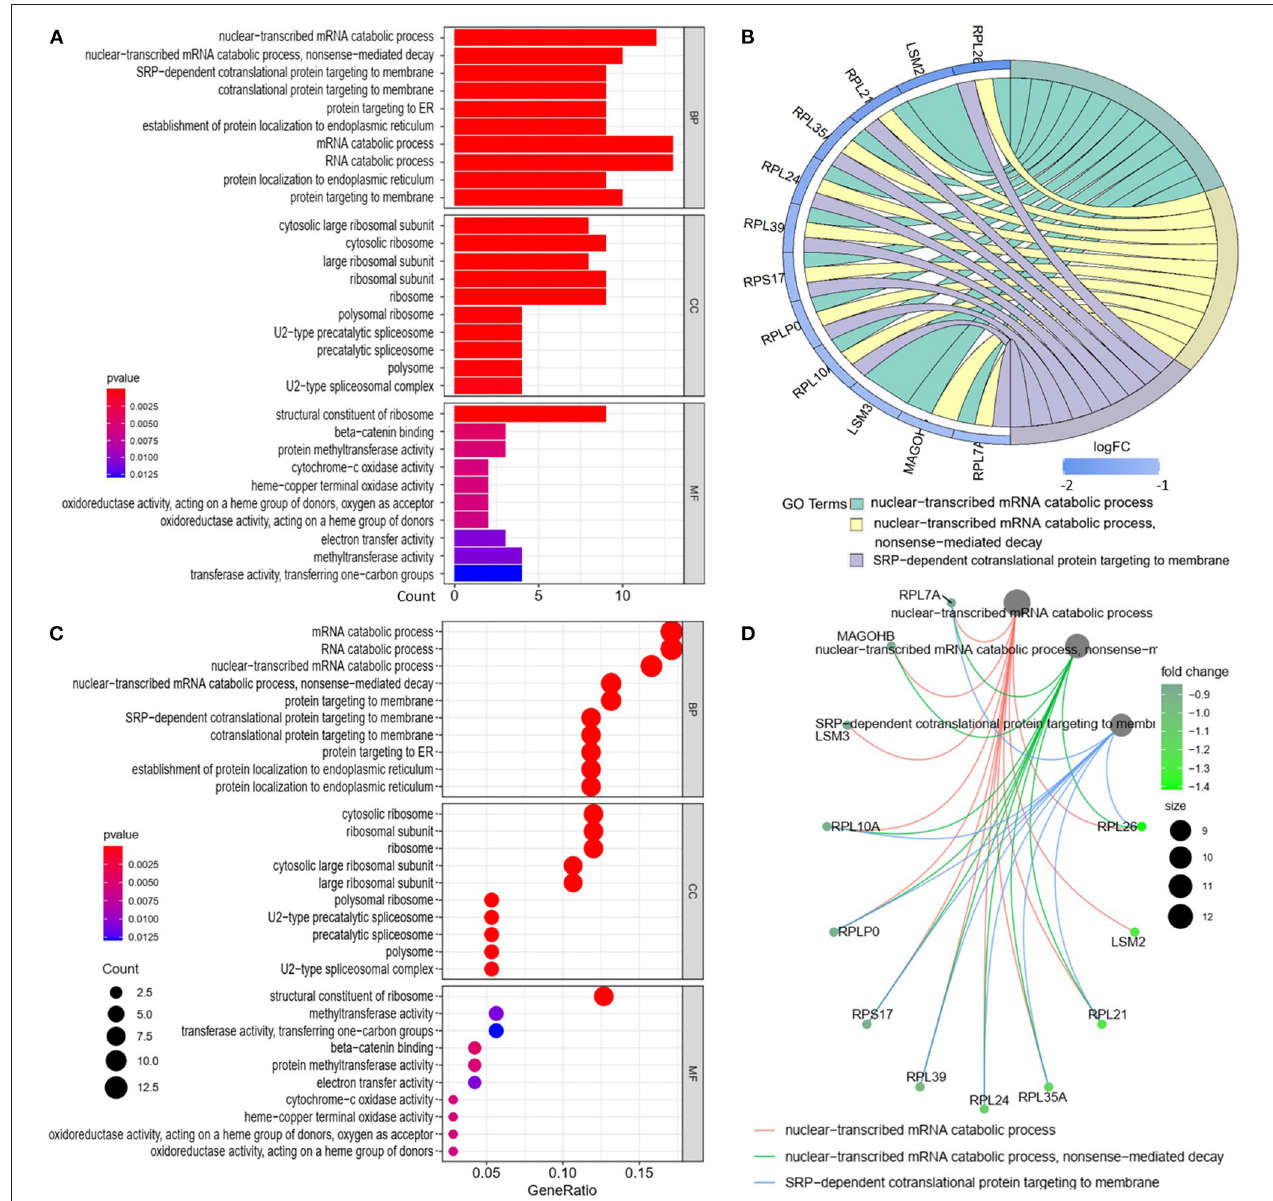
FIGURE 3 | Gene Ontology analyses of the downregulated differentially expressed genes (DEGs) between abdominal aortic aneurysm (AAA) and health control (Normal) in the biological processes (BPs), cellular components (CCs), and molecular functions (MFs). (A) GO histogram plot: the y-axis represents the term where genes are enriched, and the x-axis represents the gene enrichment number to the corresponding term. The color of the column represents the p -value. (B) The top 3 enriched GO terms. GO chord plot: the genes are linked via ribbons to their assigned terms. Blue coding next to the selected genes indicates logFC. (C) GO bubble plot: the y-axis represents the term where genes are enriched, and the x-axis represents the ratio of term genes to the total genes. The color of the dot represents the p -value, and the size of the dot represents the number of gene enrichment. (D) The top 3 enriched GO terms. GO cnetplot the genes are linked via lines to their assigned terms. The size of the dot indicates the number of genes enriched to the corresponding term. The depth of the green dots indicates fold changes.